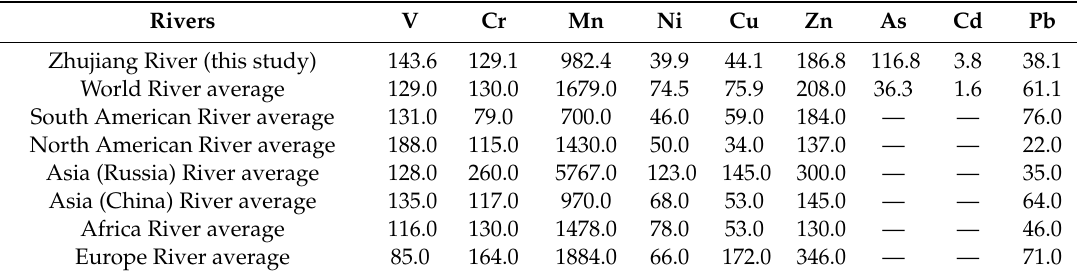
Table 4. Comparison of heavy metals in SPM of global rivers (unit in mg kg − 1 ). Rivers V